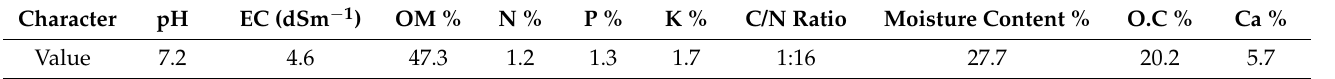
Table 3. Chemical analysis of the used compost in the experimental